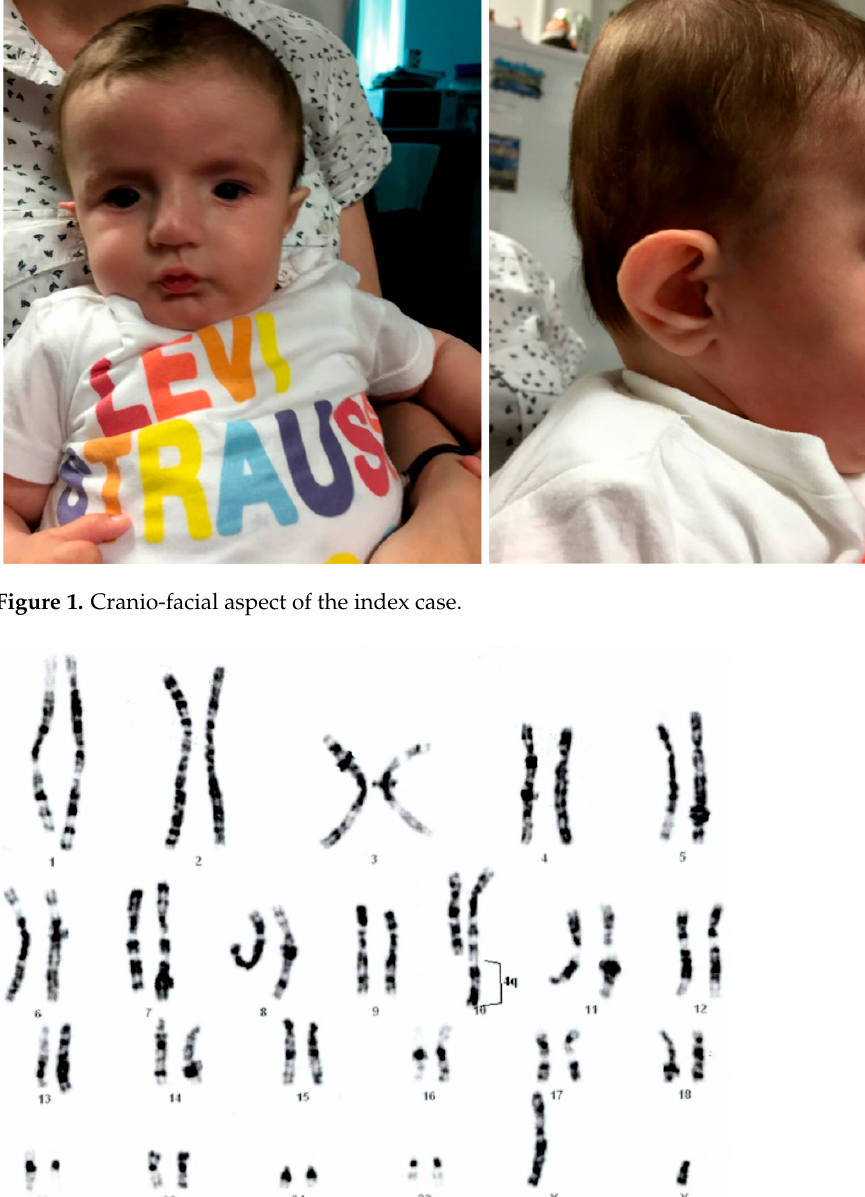
Figure 2. Child’s karyotype 46,XY,der(10)(10pter → 10q26.2::4q26 → 4qter). Using the MLPA technique with telomere probes (P036 and P070, MRC-Holland, Amsterdam, The Netherlands), we discovered a 1.5 fold amplification of the 4q35.2-4q35.1 segment (concordant with a 4q partial trisomy) and a 0.5 fold amplification of the 10qter segment (concordant with a partial 10q monosomy); we also discovered a 2-fold ampli- fication of the 4q35.2 segment (concordant with a 4q partial tetrasomy—a segment that includes the ZPF42 and TRIML2 genes). To validate these changes, we used MLPA probe P264 (for subtelomeric regions of chromosomes 1q, 2q, 3q, and 4q) and probe P286 (for subtelomeric regions of chromosomes 9q, 10q, 11q, and